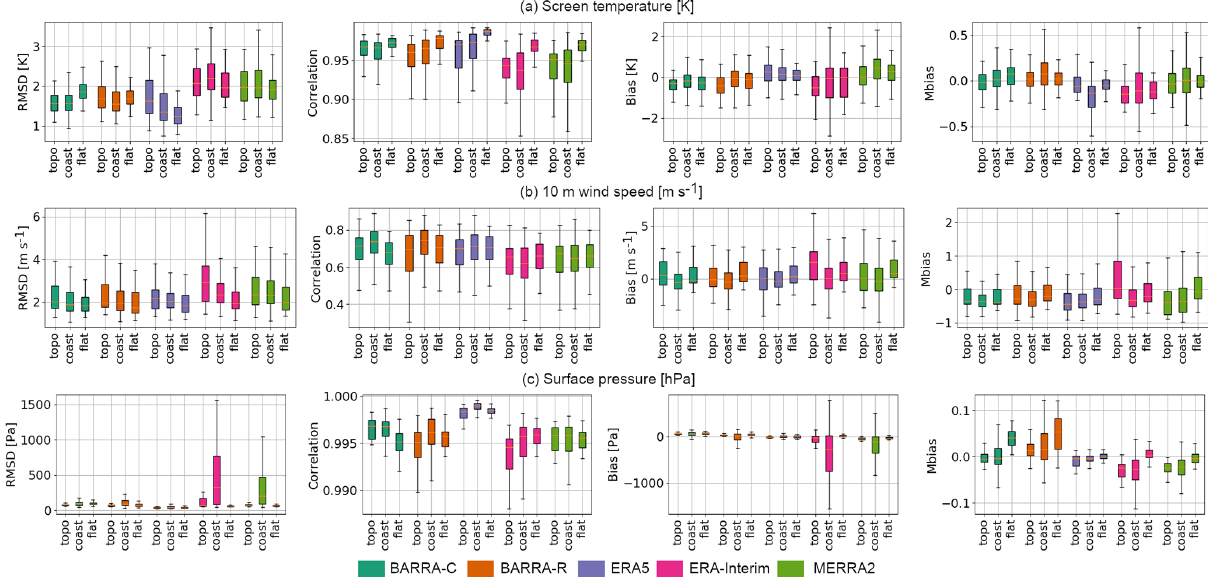
Figure 2. Box plots showing the distribution of evaluation scores of various models for (a) screen-level temperature, (b) 10m wind speed, and (c) surface pressure across the four BARRA-C domains. Three regions are analysed separately: coastal (“coast”), complex topography (“topo”), and flat, and the models are distinguished by colours. The scores are calculated from model hindcasts valid between 05:00– 07:00UTC and 17:00–19:00UTC against observations during